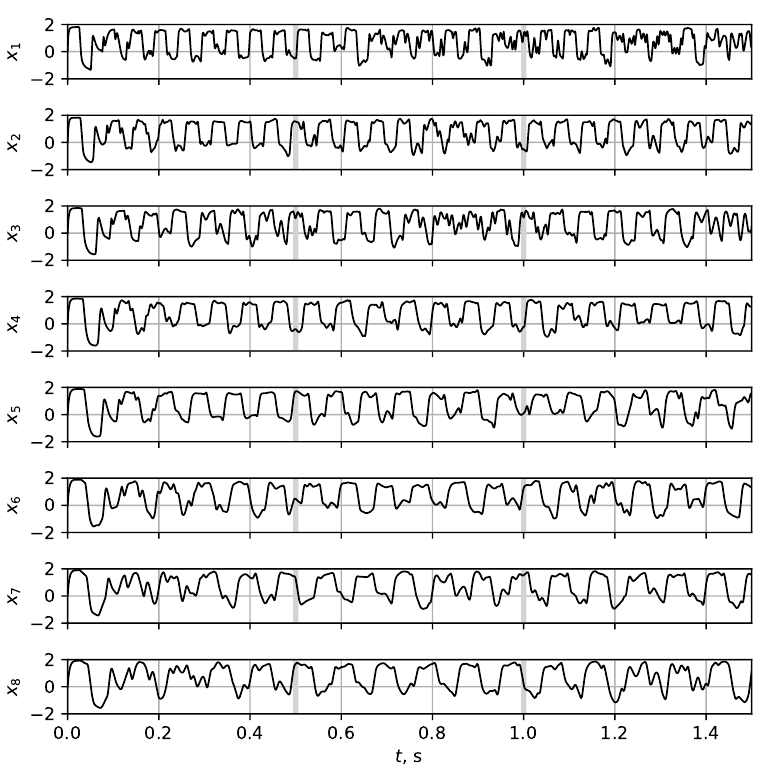
Figure 2. Time series of all eight oscillators.